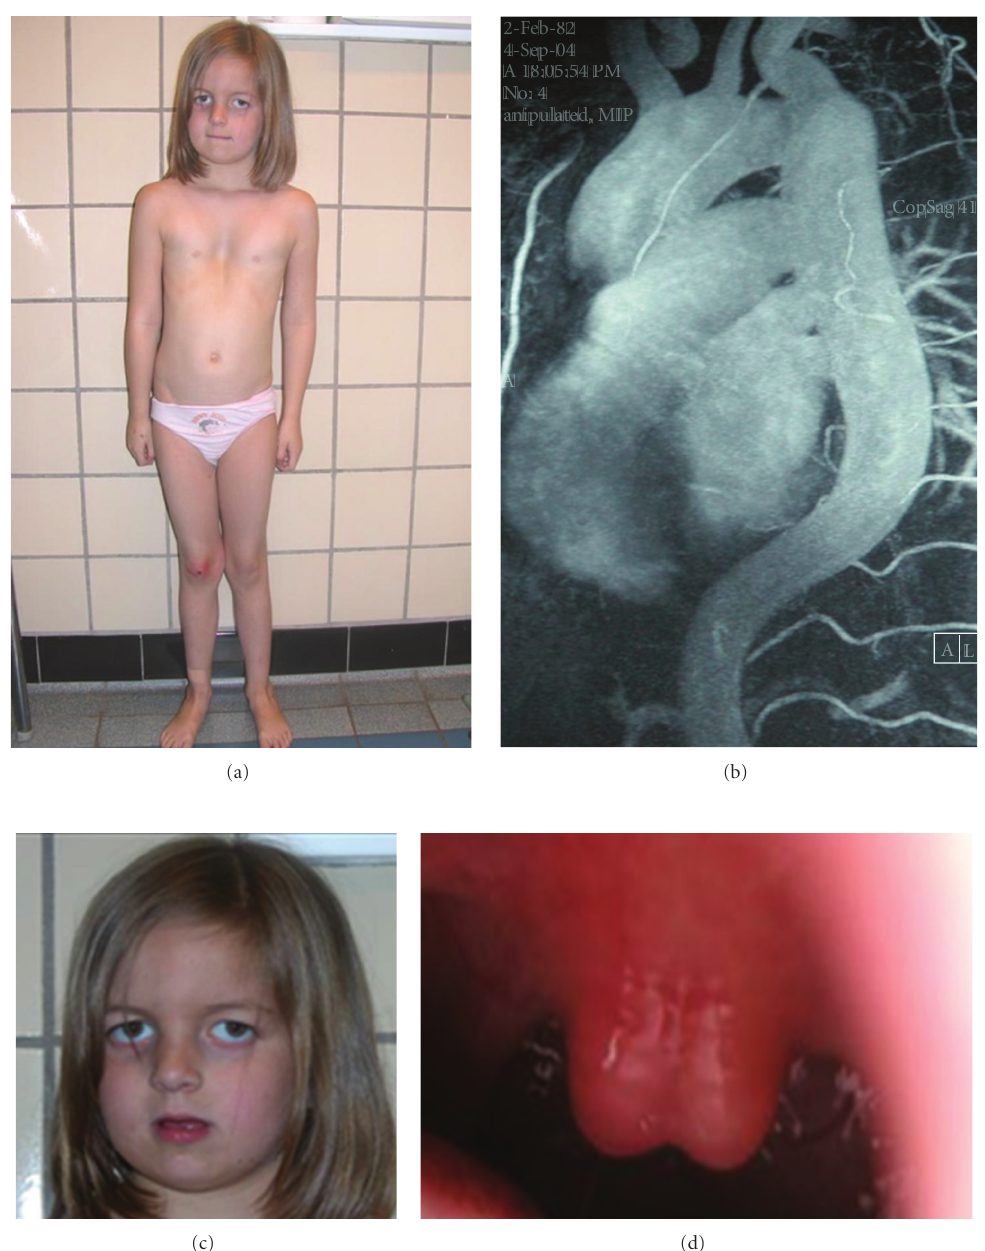
Figure 6: Features of the Loeys-Dietz syndrome Type I. Patients present a marfanoid habitus and hypertelorism (a, c), aortic dilatation (c) and a bifid uvula